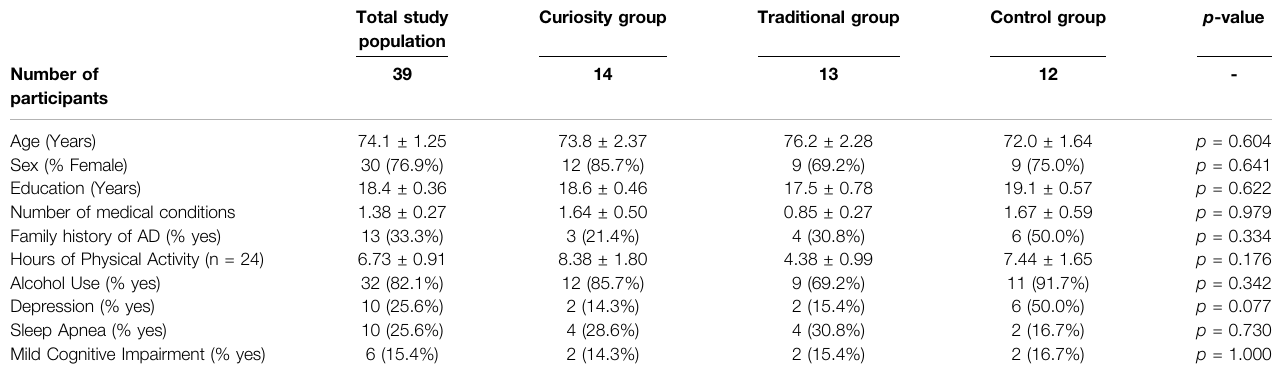
TABLE 1 | Participant demographics . Numbers are mean values ± SEM for continuous variables and numbers (%) for categorical variables. p -values were determined via one-way ANOVA for continuous data and Chi Square tests ( > 5 cases per contingency table cell) or Fisher ’ s Exact tests ( < 5 cases per contingency table cell) for categorical